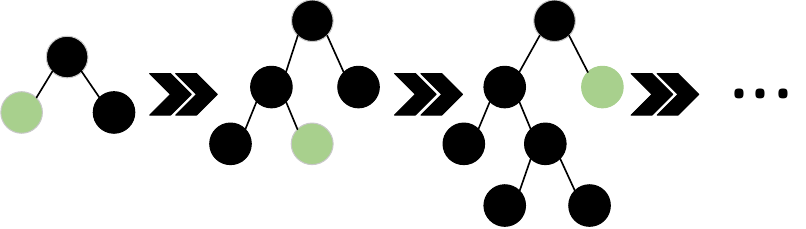
Figure 3. Schematic diagram of growth by layer. (Black nodes represent generated nodes in the tree; green nodes represent nodes selected for splitting at the current time step.)